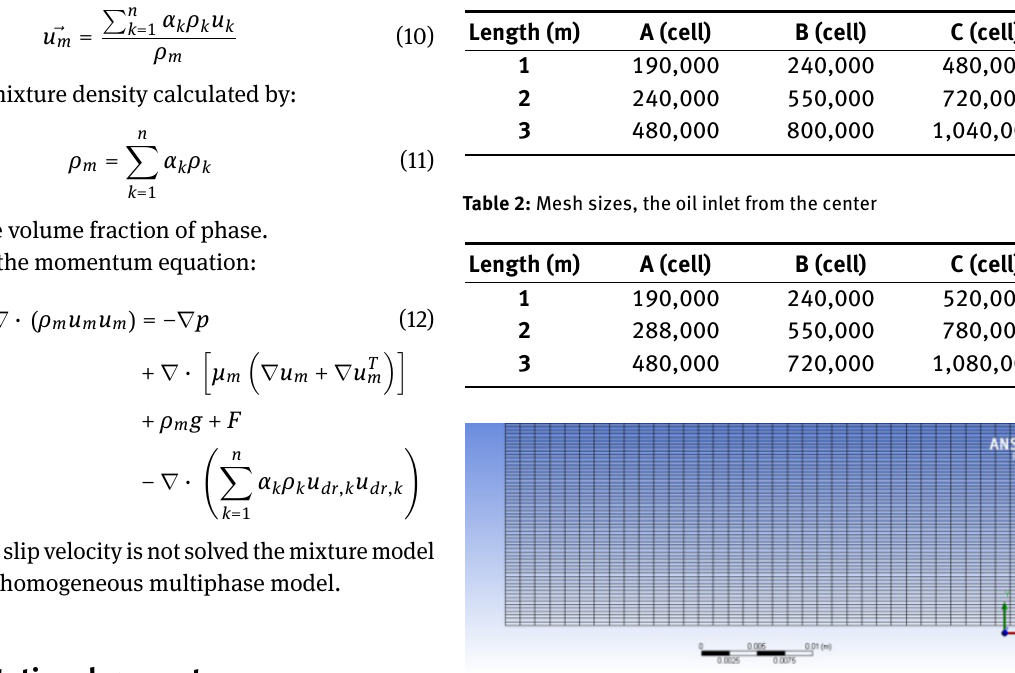
Fig. 4: The experimental rig